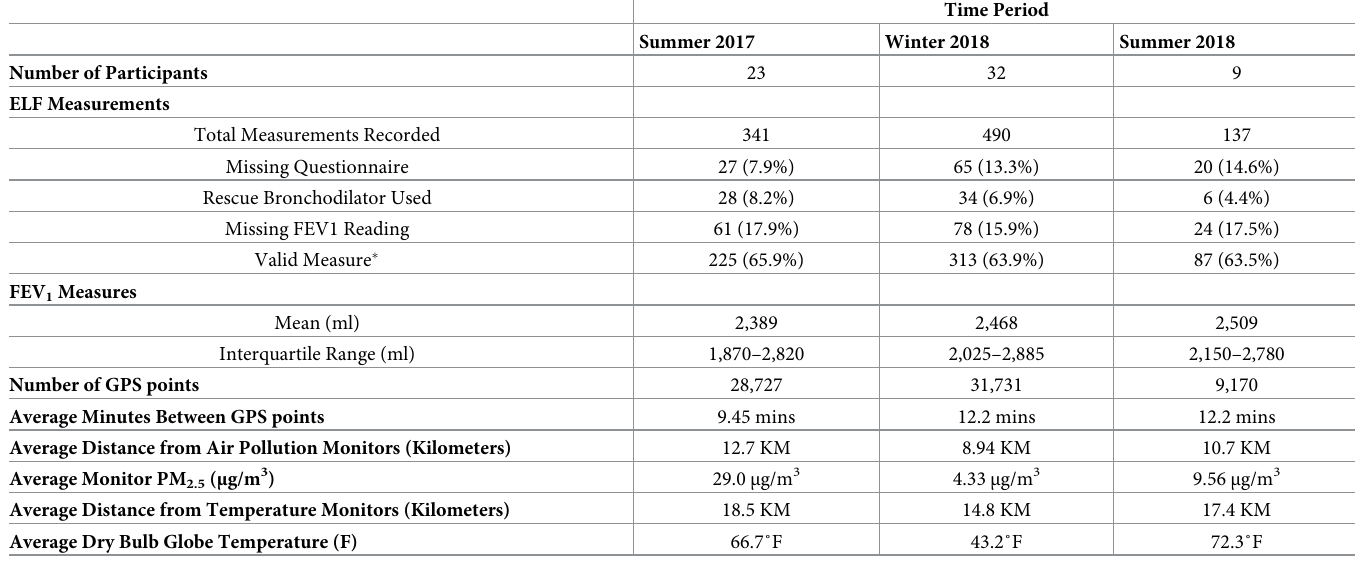
Additional details about the study population can be found in Table 1 . There were 23 partici- pants enrolled in Summer 2017 , 32 in Winter 2018 , and 9 in Summer 2018 . A total of 968 ELF measurements (spirometry and asthma symptom question responses) were collected ( Table 2 ) and 625 (64.6%) were used for the analysis of FEV , after excluding readings that were missing 1 FEV values, used rescue bronchodilator medication, or were missing questionnaire data. For 1 the rescue bronchodilator use analysis, 846 (87.4%) readings were used, following the exclu- sion of readings without questionnaire data. Table 2. Lung function and exposure metrics by time